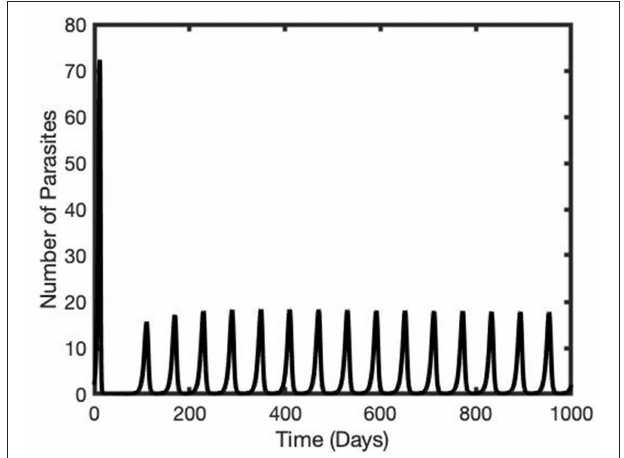
FIGURE 5 | Long-term Gyrodactylus dynamics when guppy birth is included in the system. The Figure was generated using the parameter values in Table 1 with α = 0.4/fish/day.